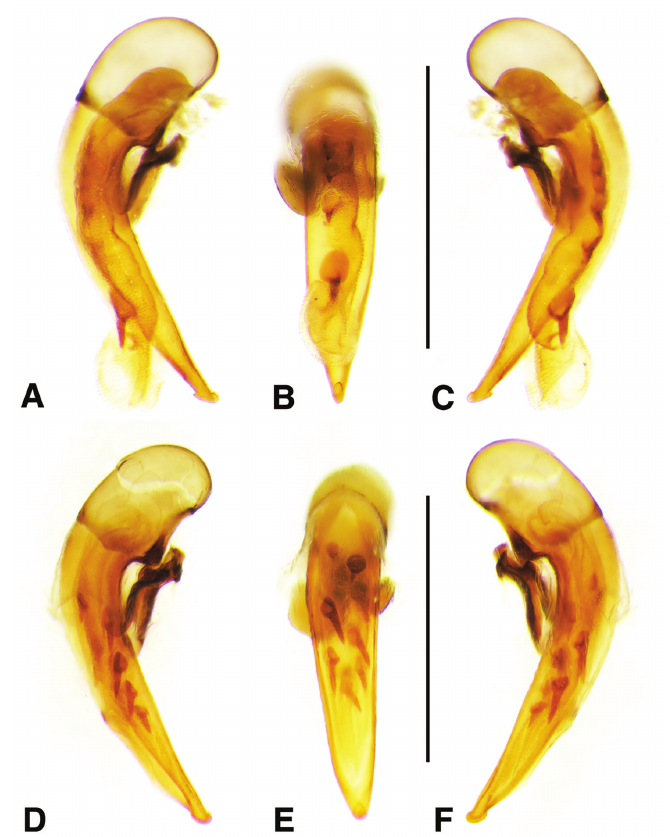
Figure 55. Digital images of male genitalia of Selenophorus parumpunctatus species group. A, D right lateral aspect B, E dorsal aspect C, F left lateral aspect. A–C S. obtusoides sp. n. D–F S. parumpunctatus Dejean. Scale bars 1